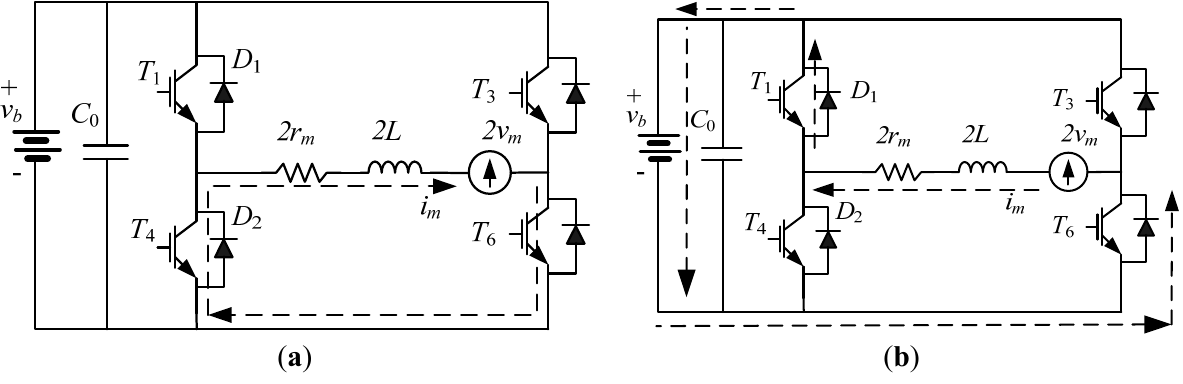
Figure 4. Current direction of the power converter in energy-regeneration braking mode: when T4 is ( a ) ON ; and ( b ) OFF .